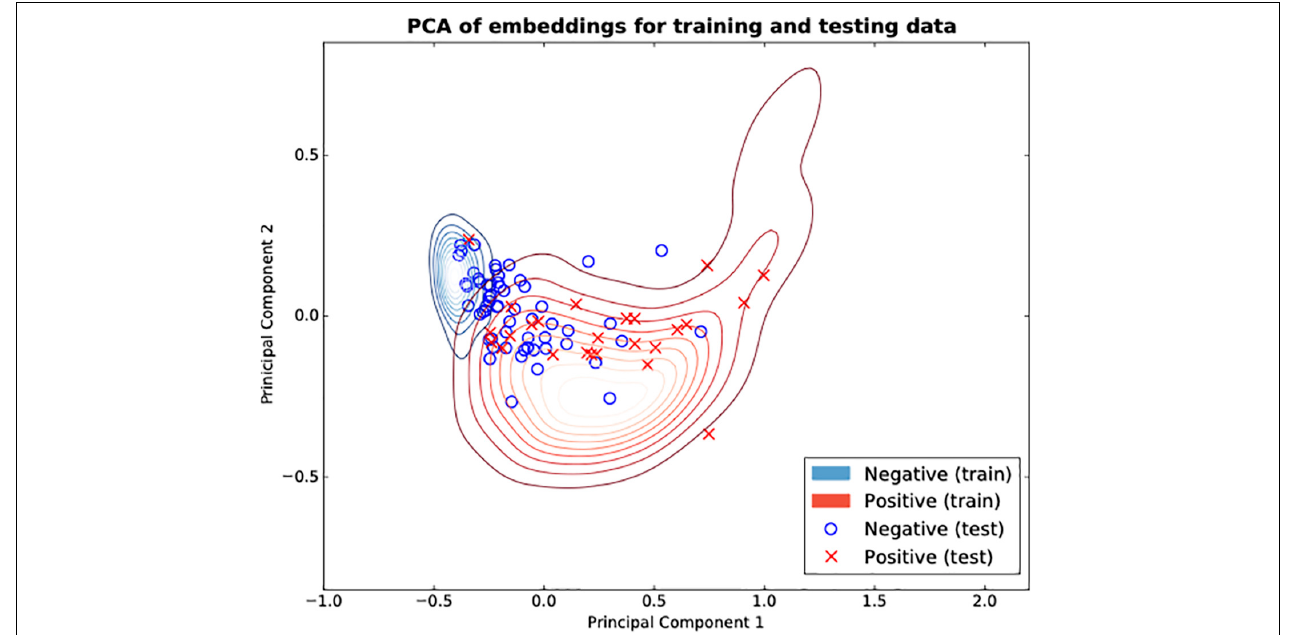
FIGURE 4 | The convolutional neural network for classifying the training dataset (contour maps) and the test dataset (symbols) from the December 5, 2018 M w 7.5 teleseimic earthquake. Shown in red are seismograms with an earthquake, seismograms without earthquakes are shown in blue.